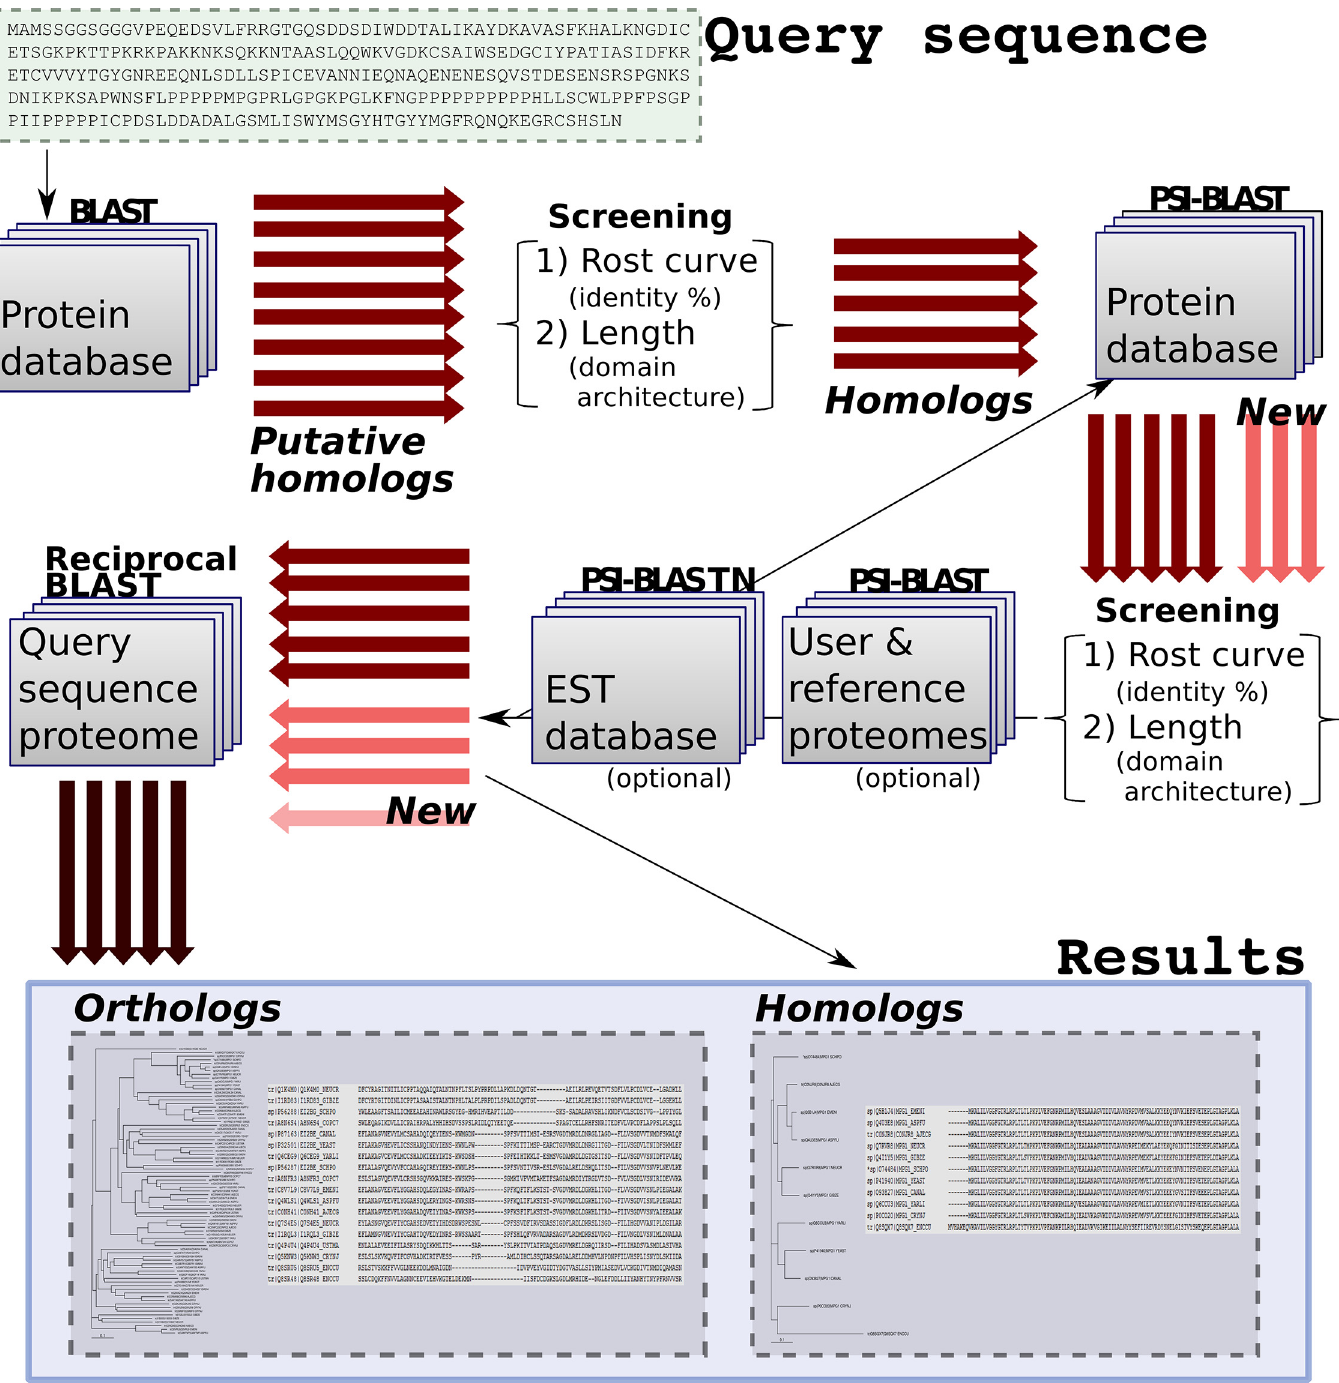
Fig 1. Steps followed by the orthoFind algorithm. It starts with a query sequence (or sequences) and a BLAST search to find putative homologs (represented by wide arrows). Then, the candidates have to pass through two filters: the Rost curve to remove sequences with low identity values, and the length filter to evaluate the domain architecture of the sequences. Next, a PSI-BLAST search can find new homologs, and the same filters are used again. Optionally, it is possible to look for additional homologs with a new PSI-BLAST search versus either a database of reference proteomes, sequences from the user or an EST database; these new results are also filtered by length and using the Rost curve. Finally, orthologs are discriminated by a RBHB, and the results are separated in homologs and orthologs, both of them displayed as a multiple alignment and as a phylogenetic tree.